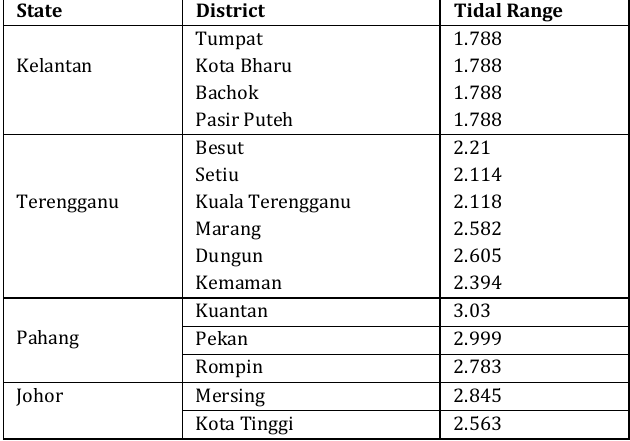
Table 5: Tidal range along the East Coast of Peninsular Malaysia.